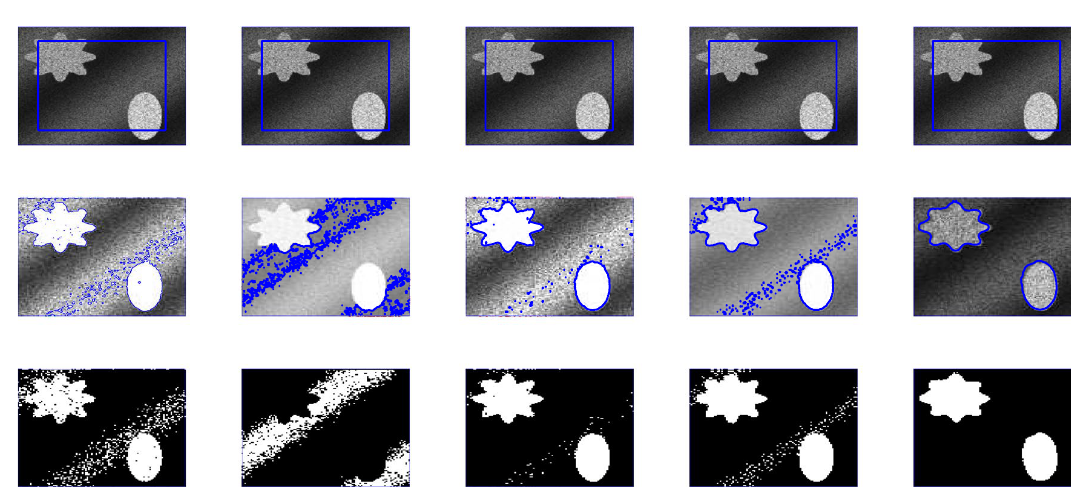
Figure 8. First, second, third and fourth columns are the segmentation results of Wu et al. 24 , Li-kim 15 , Wu et al. 12 and Krinidis et al. 31 , respectively. The fifth column is the segmentation result of proposed model with p = 0.5 , µ = 0.7, and σ =